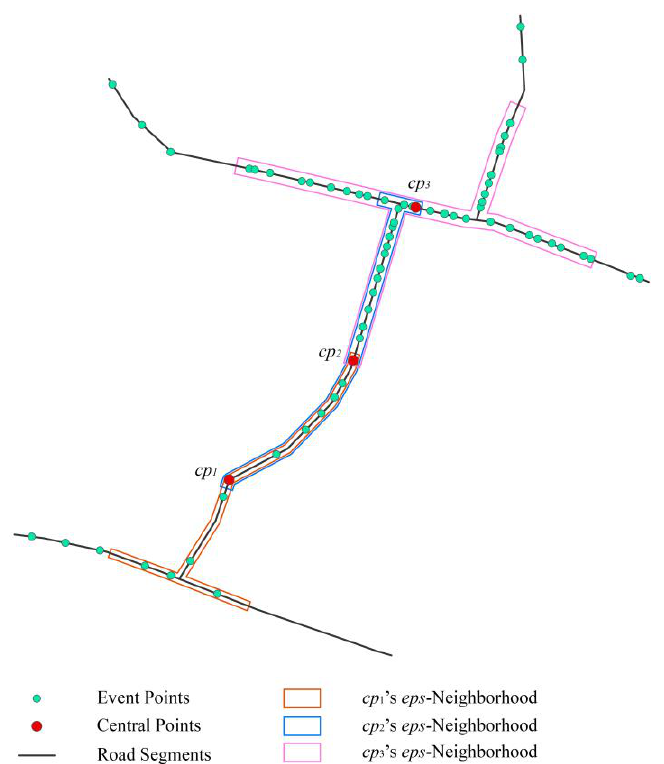
Figure 2. Network space density-based spatial clustering of applications with noise (NS-DBSCAN) algorithm reached the peak of local density from cp1 to cp3 ( cp3 is the local density